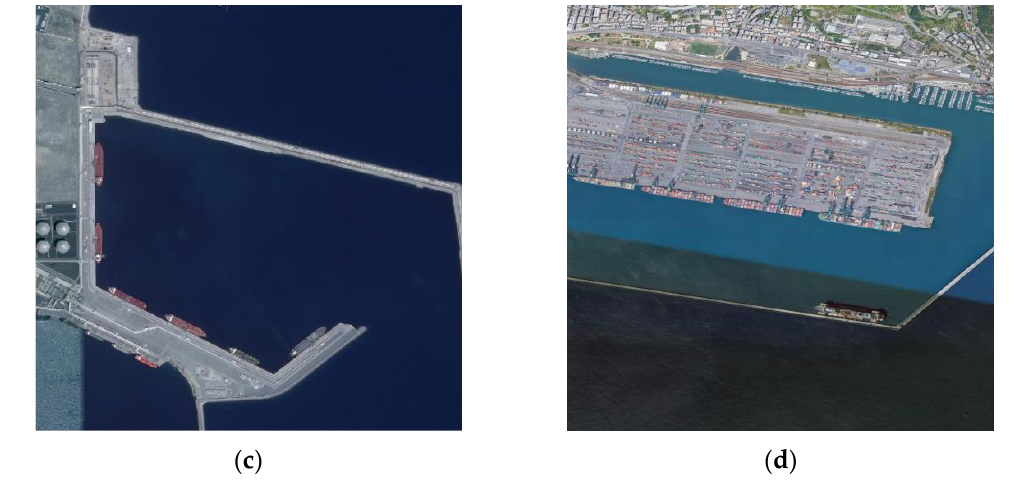
Figure 7. ( a , b ) are images without ships. ( c , d ) are images with Figure 7. ( a ) and ( b ) are images without ships. ( c ) and ( d ) are images with ships.